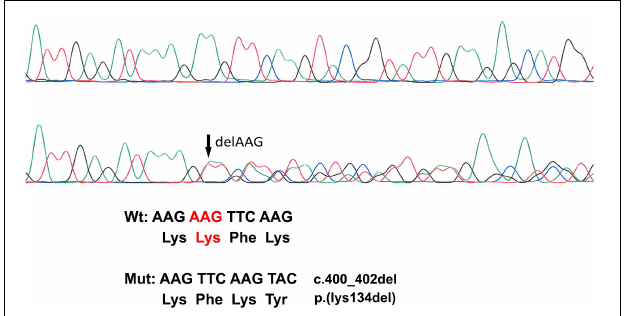
FIGURE 2 | Sanger Sequencing Analysis. The top electropherogram is from the non-affected control DNA sample while the bottom one is from patient I DNA analysis showing a three-amino-acid deletion (c.400_402del) (marked with an